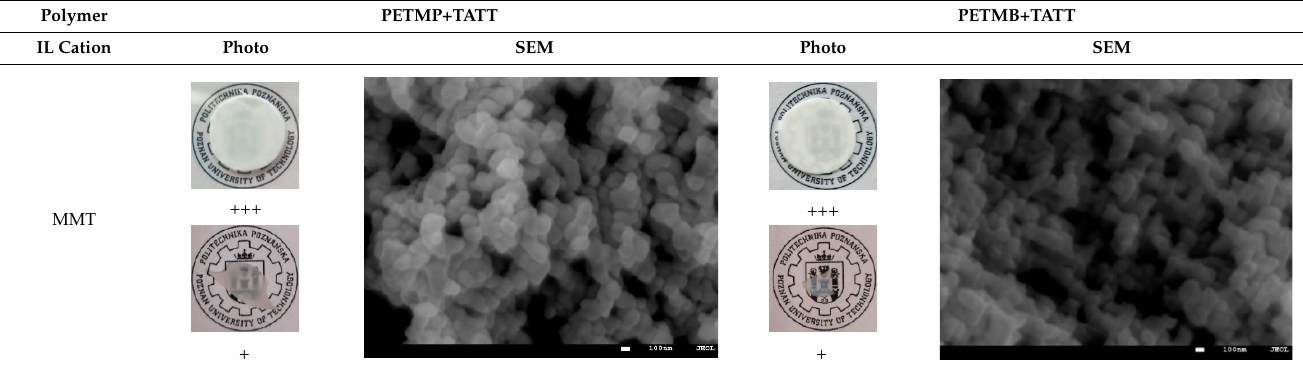
Table 3. Photos of ionogels, as well as photos and SEM micrographs of the polymer matrix after solvent removal for the studied materials with different 1,2,4-triazolium ionic liquids used with propylene carbon as a solvent mixture. The scale of the opacity is as follows: (+++)— white opaque; (++)—semi-opaque, (+)—iridescent, and ( − )—fully transparent sample.